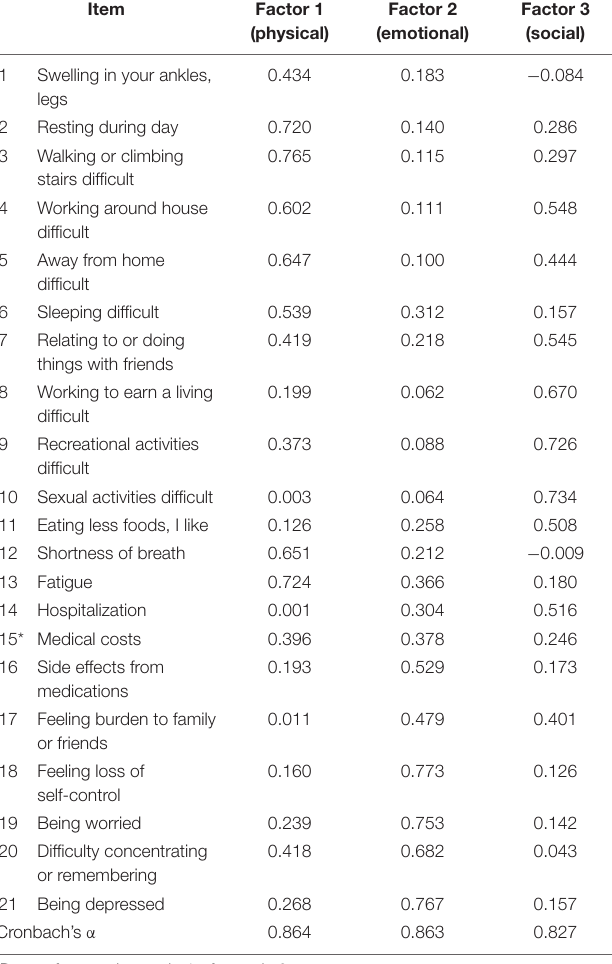
TABLE 4 | Factor analysis of the MLHFQ items. TABLE 5 | Convergent evidence: Pearson correlation coefficients between the factors of Minnesota Living with Heart Failure Questionnaire (MLHFQ), 36-Item Short Form Health Survey (SF-36), and exercise capacity in the overall